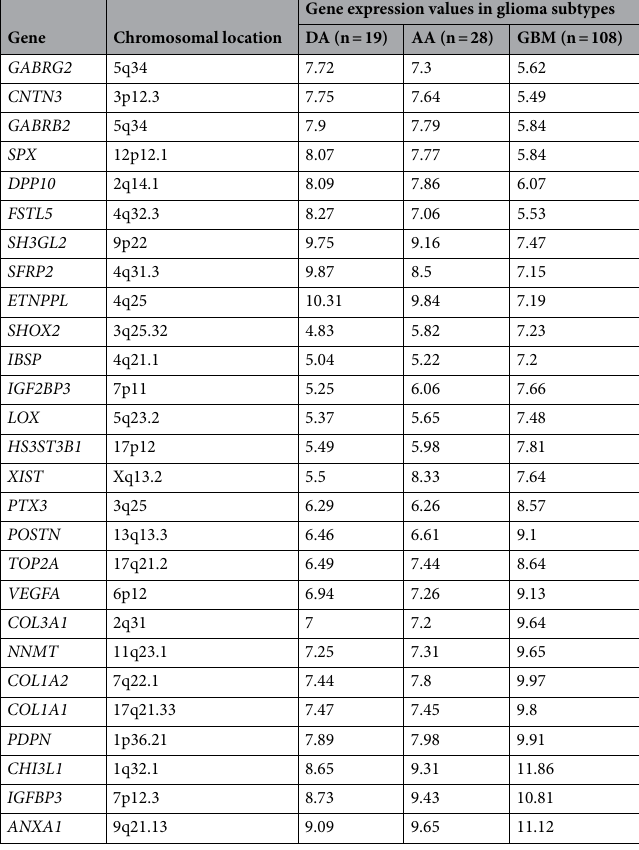
astrocytoma, AA anaplastic astrocytoma, GBM glioblastoma